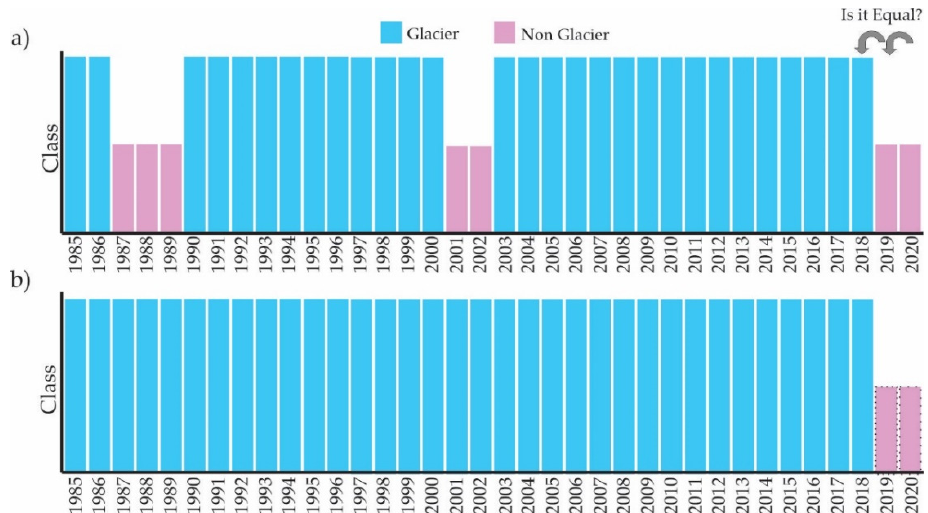
Figure 8. Effect of the frequency filter application: ( a ) time series of the original classification (before the filter application), and ( b ) time series of the filtered classification.